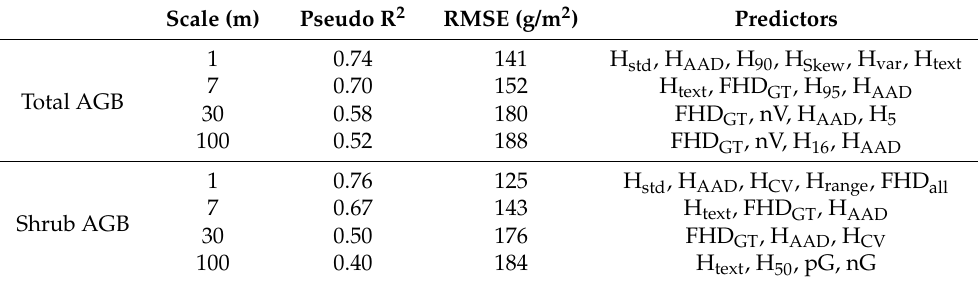
Table 3. Results of the RF regression using raster data processing for total and shrub biomass at different resolutions representing 1-ha plots.